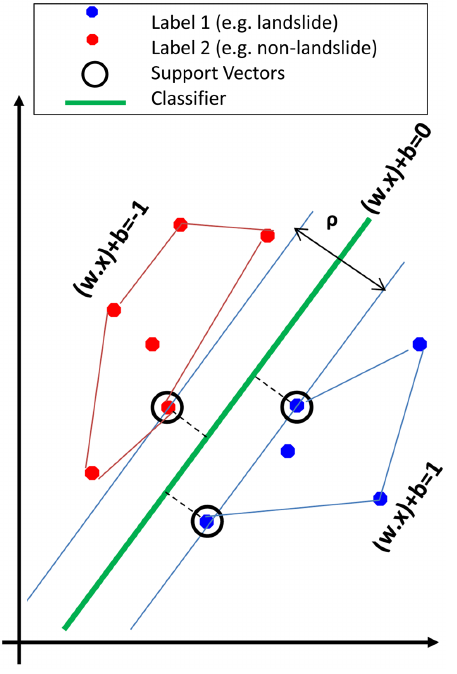
Fig. 1. Support Vector Machine (SVM) model concept for classification.